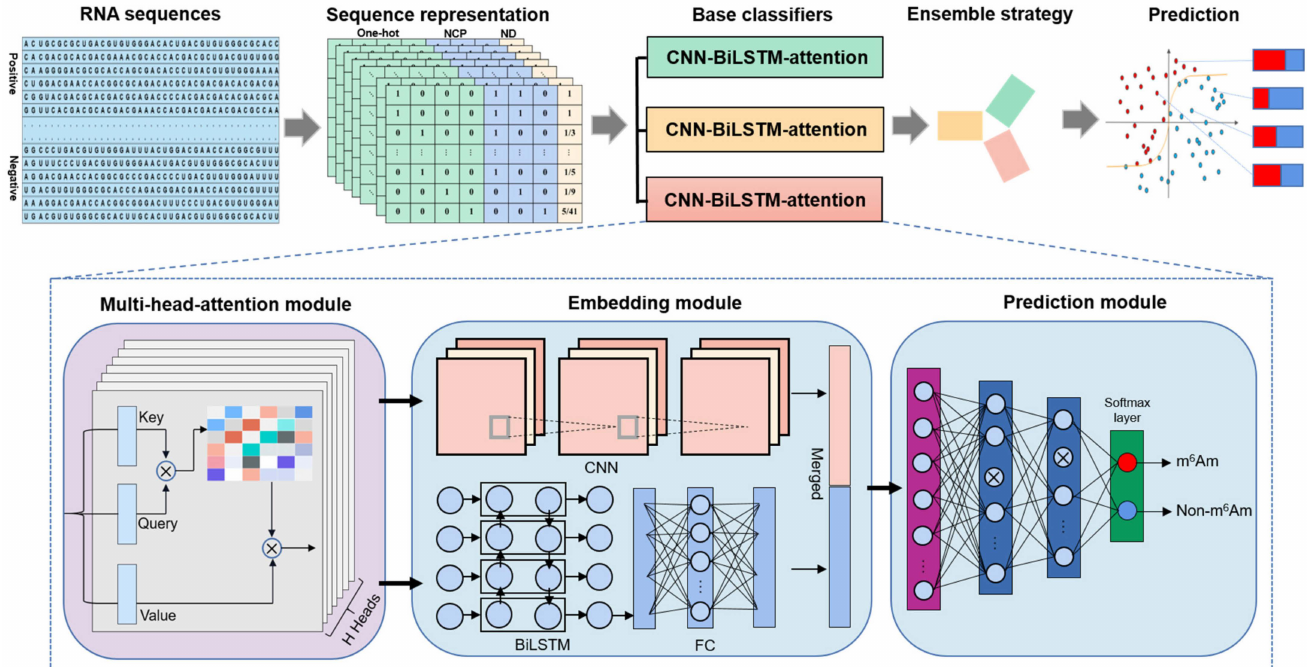
Figure 2. The workflow and architecture of DLm6Am. DLm6Am identifies m 6 Am sites from RNA sequences by several key steps, including feature extraction, model construction, and m 6 Am site prediction. DLm6Am integrates three CNN-BiLSTM-attention models into an ensemble deep learning predictor, in which each base classifier includes multi-head-attention module, embedding module, and prediction